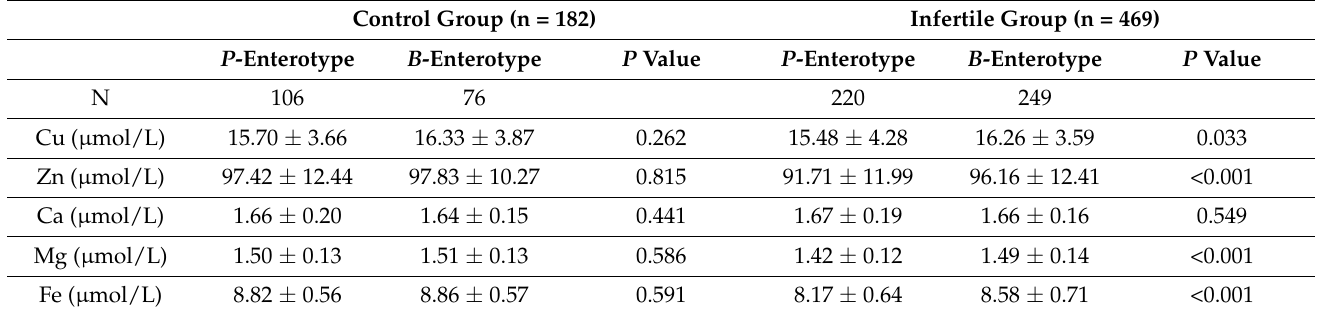
Table 2. Whole blood trace element levels of the study population according to enterotypes in healthy and infertile